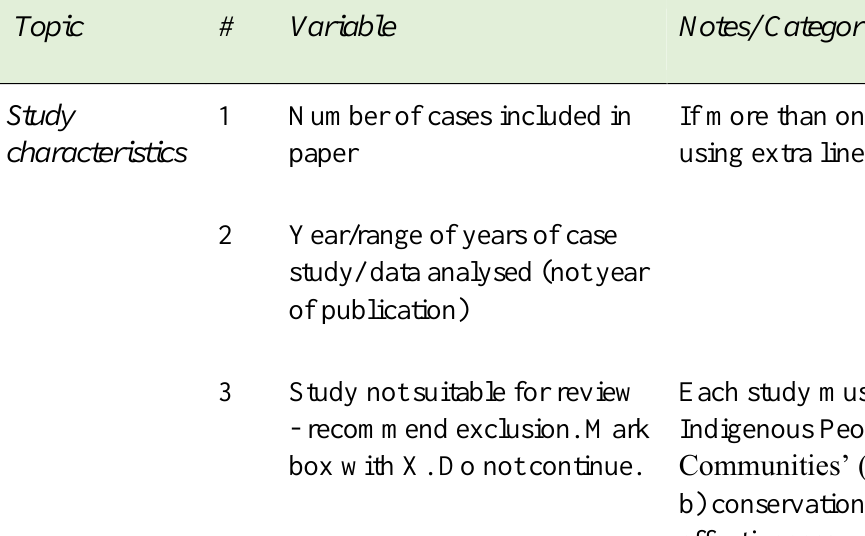
Table A3.1 Review protocol